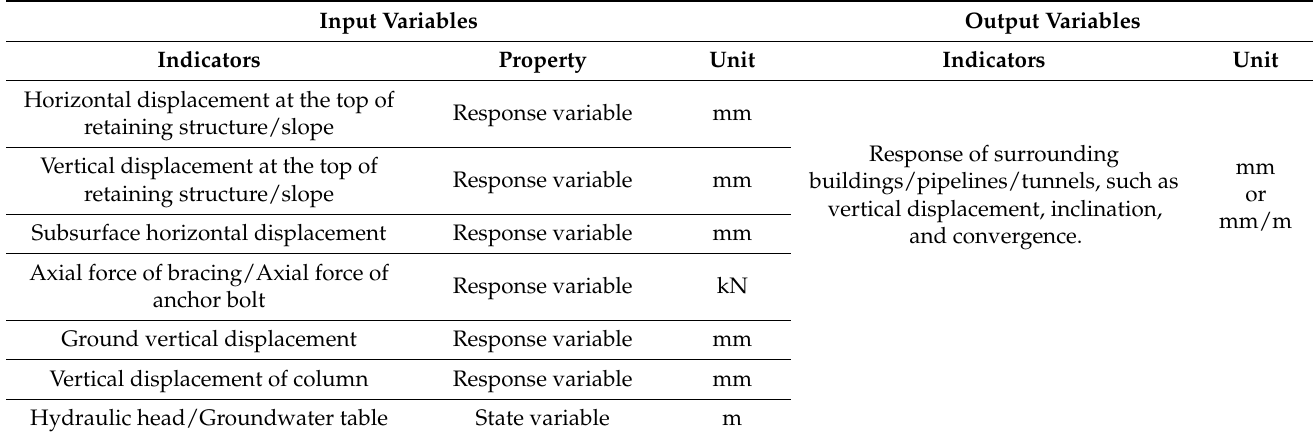
Table 3. The variables of the prediction